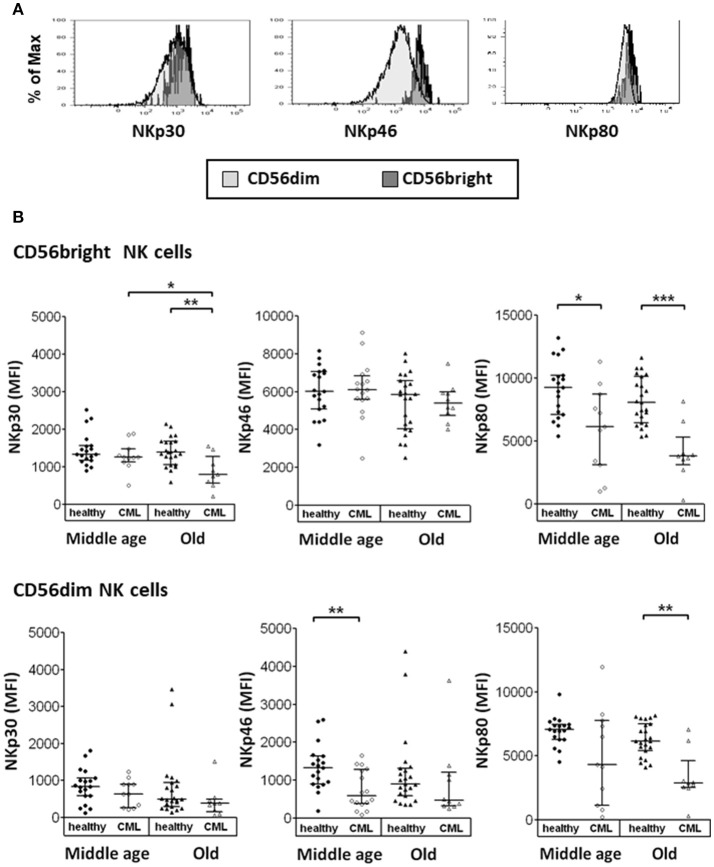
Expression of Natural Cytotoxicity Receptors (NCRs) on CD56bright and CD56dim NK cells. (A) Representative histograms for NKp30, NKp46, and NKp80 are shown (the shaded area of light gray, the CD56dim cells, the shaded one of gray, the CD56bright cells). Results were expressed as Median Fluorescence Intensity (MFI), measured in the total of cells. (B) Expression of activating receptors NKp30, NKp46, and NKp80 on CD56bright and CD56dim NK subsets from healthy individuals and TKI-treated CML patients, stratified according to age (middle-aged 35–65 years and old >65 years). Number of donors: NKp30 and NKp80 middle-aged healthy n = 19, middle-aged CML n = 11, old healthy n = 23, and old CML n = 9; NKp46 middle-aged healthy n = 19, middle-aged CML n = 16, old healthy n = 23 and old CML n = 10. The results were expressed as median with interquartile range. P-values were determined comparing middle age with old and healthy with TKI-treated CML patients and were considered significant at p <0.05. *
p < 0.05; **p < 0.01; ***p < 0.001.